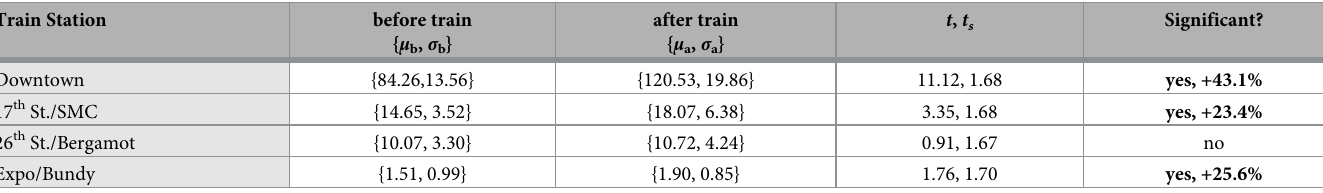
Table 3. Statistical tests on reported crime in the vicinity of light rail station locations in Santa Monica, CA, 2006–2019, before and after opening of the Expo Line light rail extension. Train